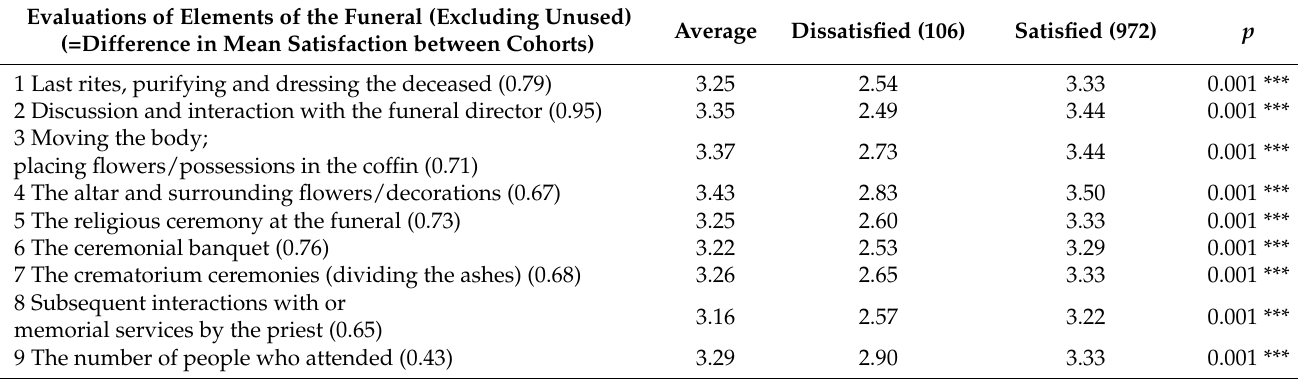
Table 1. Evaluation of elements of the funeral (in order of ritual performance, not